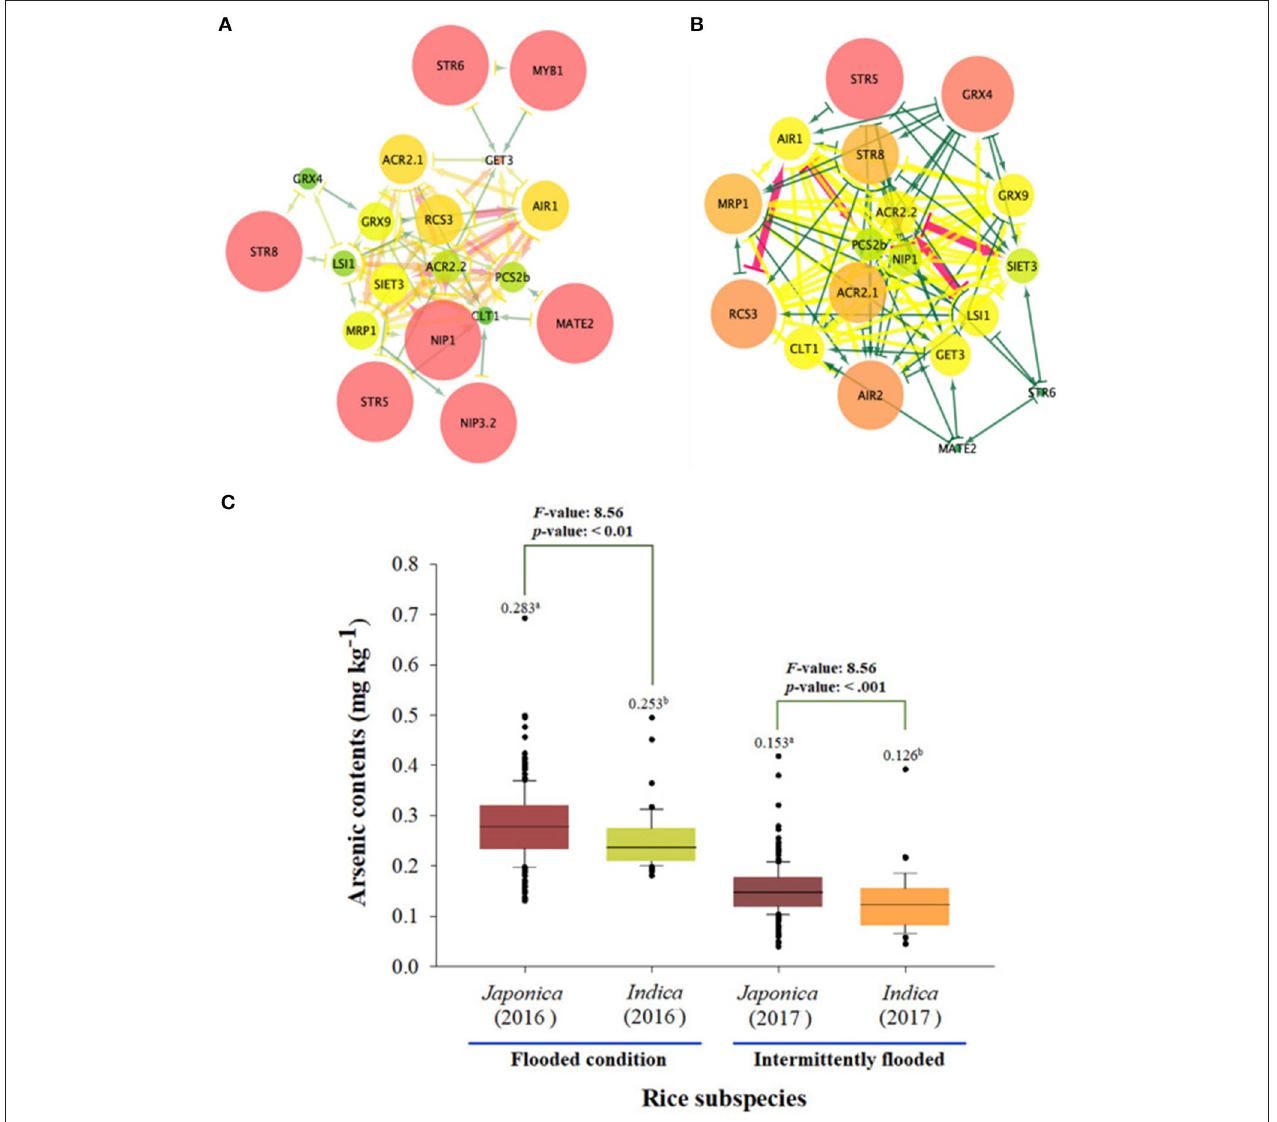
FIGURE 4 | Expression network analysis of As genes between japonica and indica population. (A) The expression network of As-related genes within the japonica population. (B) The expression network of As-related genes within the indica population. (C) As content of japonica and indica under flooded and intermittently flooded conditions. a and b indicates whether there is a statistically significant difference between